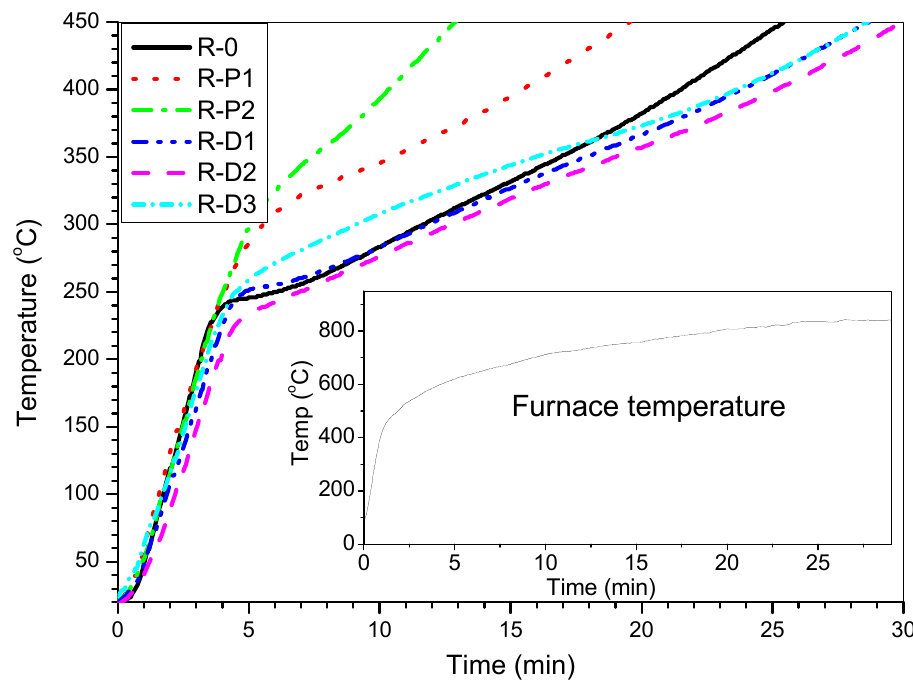
Figure 2. Thermal insulation curves for intumescent coatings with CNTs or PER-CNTs solid dispersions (measured during a furnace test). Table 2. Viscosity of the intumescent paints and results of the furnace test and thermogravimetric analysis of the intumescent coatings with CNTs or PER-CNTs solid disperions.